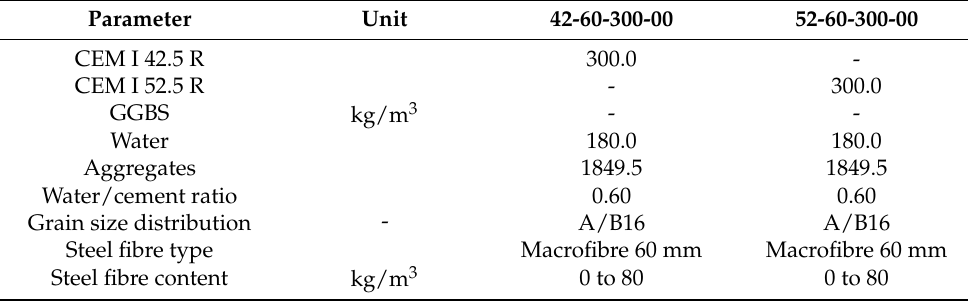
Table A3. Concrete mix designs for the variation of the cement type.